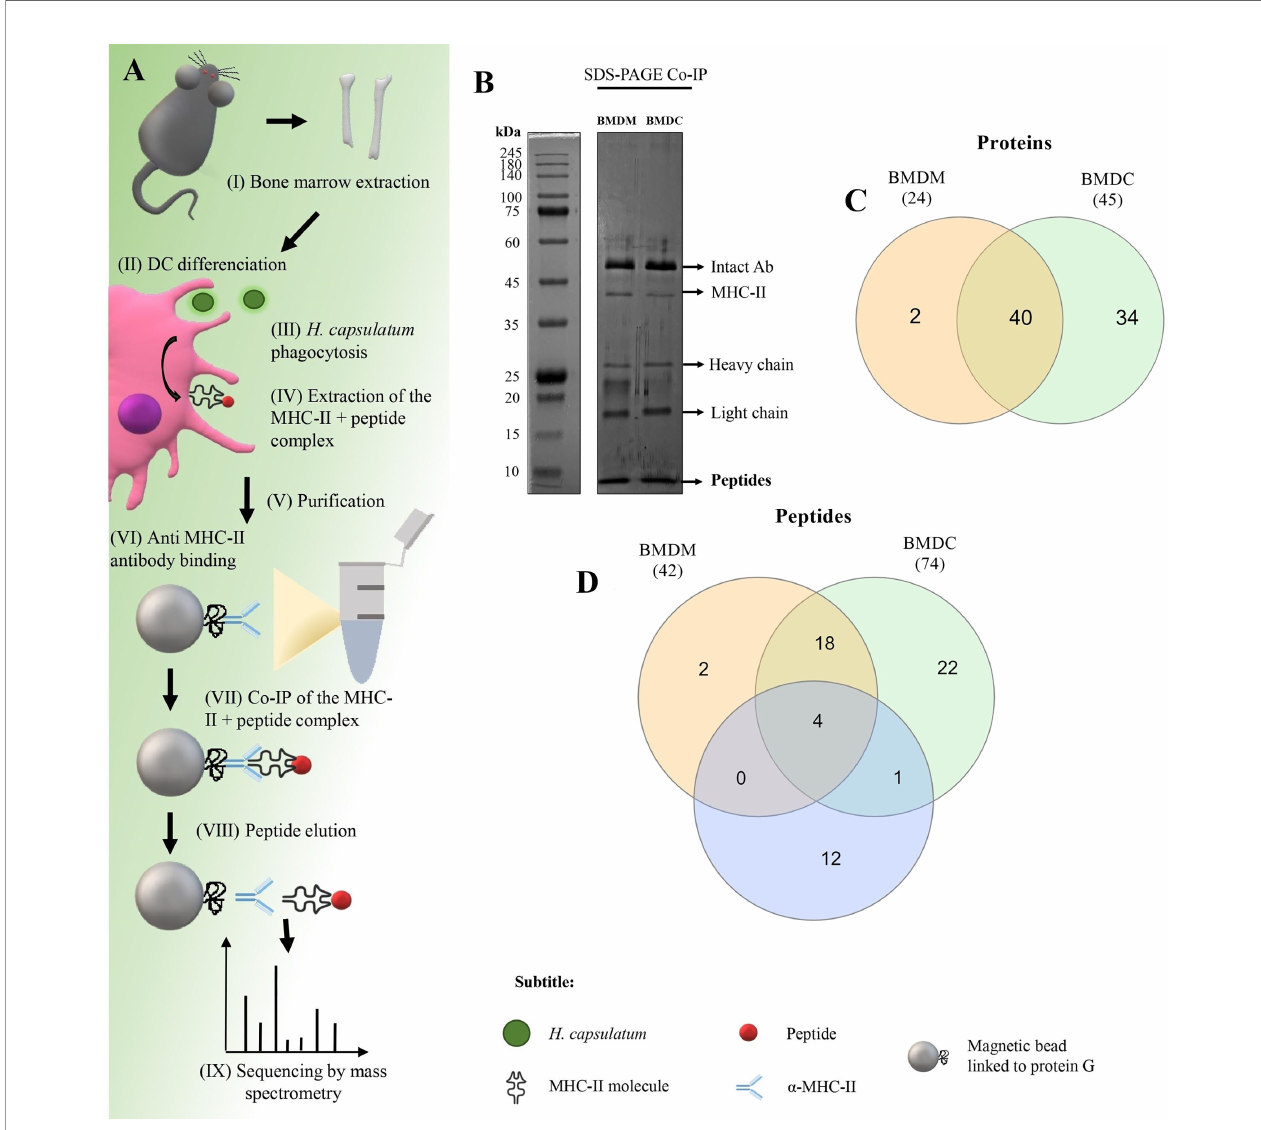
MHC-II extraction was performed. (V and VI) Magnetic beads containing G protein were complexed with anti-mouse IgG2a I-Ab. After the incubation period, the amount of antibody in the supernatant was measured and total binding of antibody to magnetic beads was achieved. (VII) The extract was incubated for af fi nity capture of the MHC-II + peptide complexes. (VII) Then the peptides were dissociated from the column after acid denaturation and (IX) the eluted peptides were identi fi ed by nanoLC-MS/MS. (B) 1-D SDS-PAGE of the eluted peptide sample. Electrophoresis gels were stained with silver nitrate. kDa: kilodaltons. (C) Venn diagram showing common and exclusive proteins obtained through 2-D gel electrophoresis and Co-IP of H. capsulatum peptides linked to MHC II from BMDM and BMDCs. Orange ellipse: Proteins presented by BMDM. Green ellipse: Proteins presented by DMDC. Blue ellipse: proteins sequenced from 2-D gel extraction. Crossing the ellipses represents the proteins that were identi fi ed in common among Co-IP (BMDM and BMDCs) and 2-D gel electrophoresis. (D) Venn diagram showing common and exclusive peptides obtained Co-IP of H. capsulatum peptides linked to MHC II from BMDM and BMDCs. The results represent peptides sequenced by nanoLC-MS/MS. Orange ellipse: peptides presented by BMDM. Green ellipse: peptides presented by DMDC. Crossing the ellipses represents the peptides that were identi fi ed in common among BMDM and